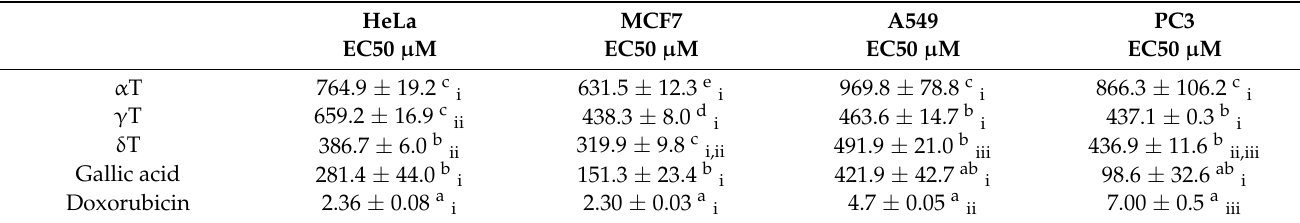
Table 1. Effect of pure compounds on the viability of cancer